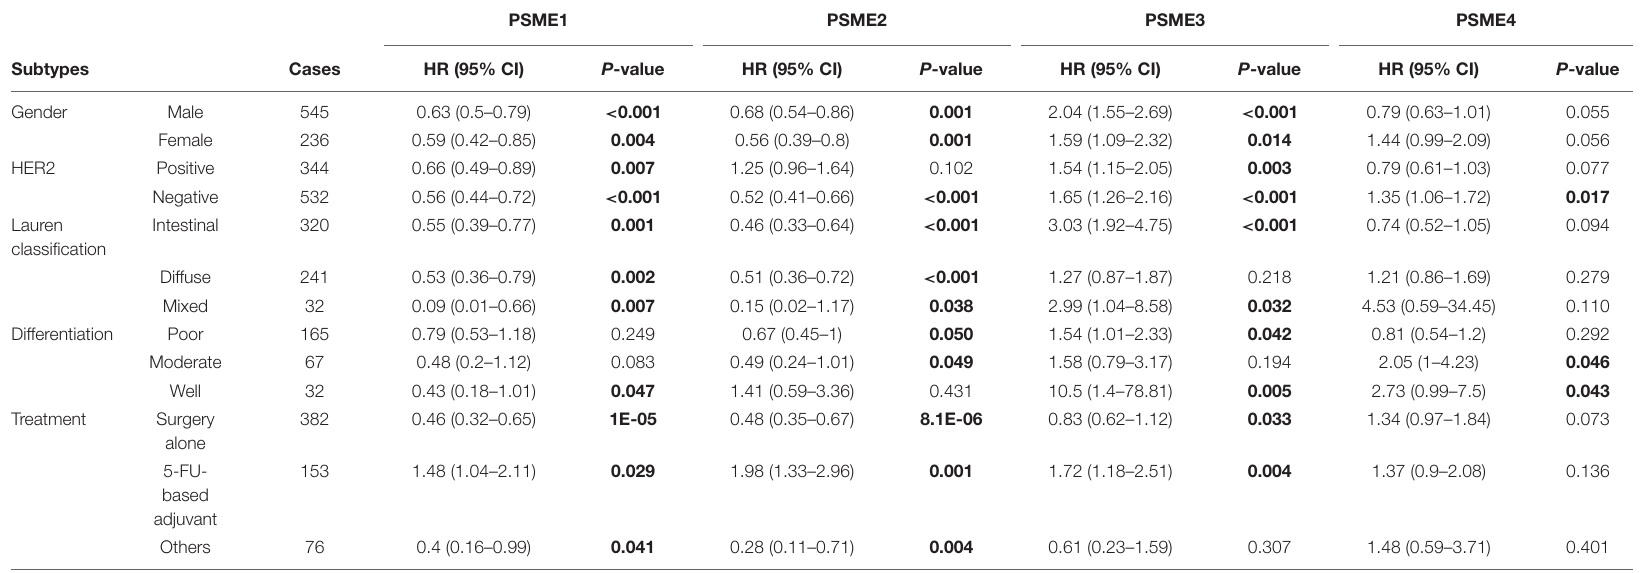
TABLE 1 | The correlation between PSME genes and OS in different subtypes of GC patients (Kaplan–Meier